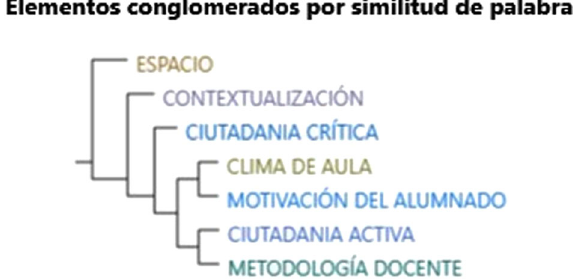
Fig. 3 Cluster analysis: conglomerated categories by word